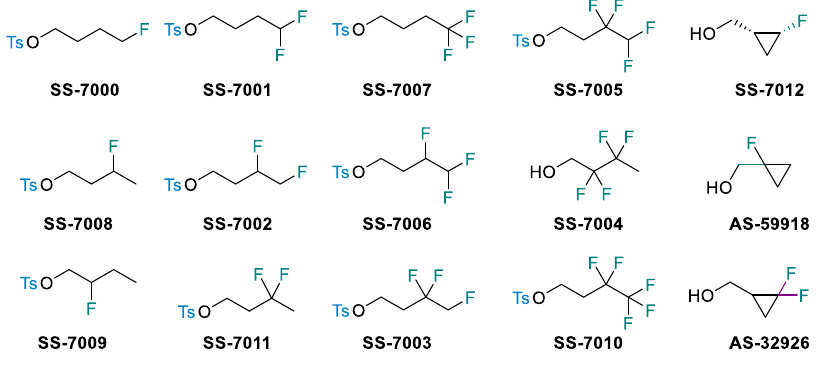
Figure 45. Compounds